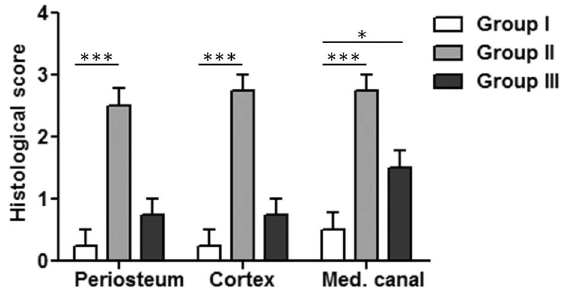
Fig. 4. Histological grading score histogram. The histogram shows a high statistically significant difference in the histological grading score in periosteum, cortex and medullary canal of group I versus group II and a difference in the score of the medullary canal of group I versus group III (two-way ANOVA, ***P , 0.001; *P , 0.05; n=4).